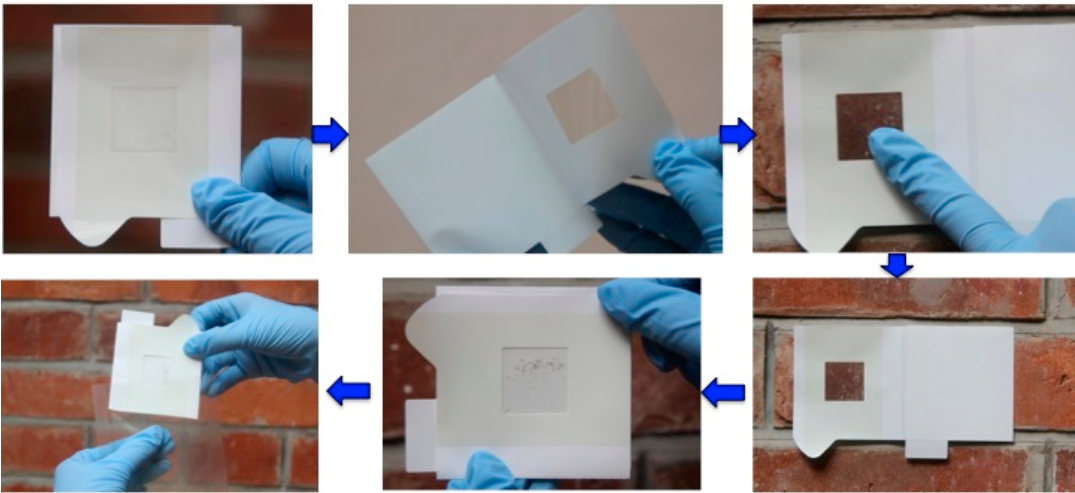
Figure 2. The adhesive sheet sampling device developed for non-invasive/non-destructive sampling from various solid surfaces. The adhesive sheet can collect biofilm (the microbial community and the decomposed materials on the solid surface) from the surface to the deepest layer by a series of continuous peeling-off sampling of the biofilm at the same sampling position to analyze the stratified microbiome structure.